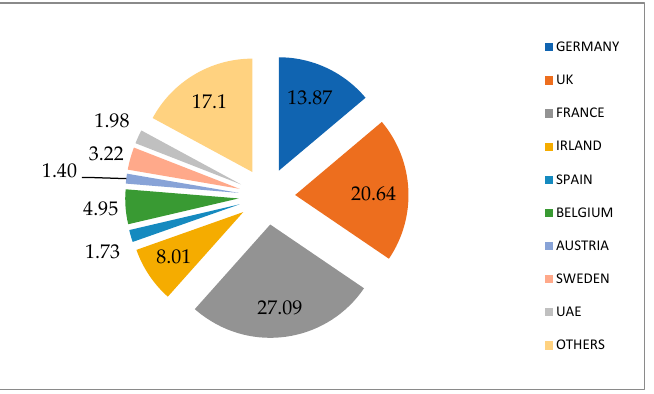
Figure 6. The share of migrant physicians from Romania, according to the country of destination, 2017.